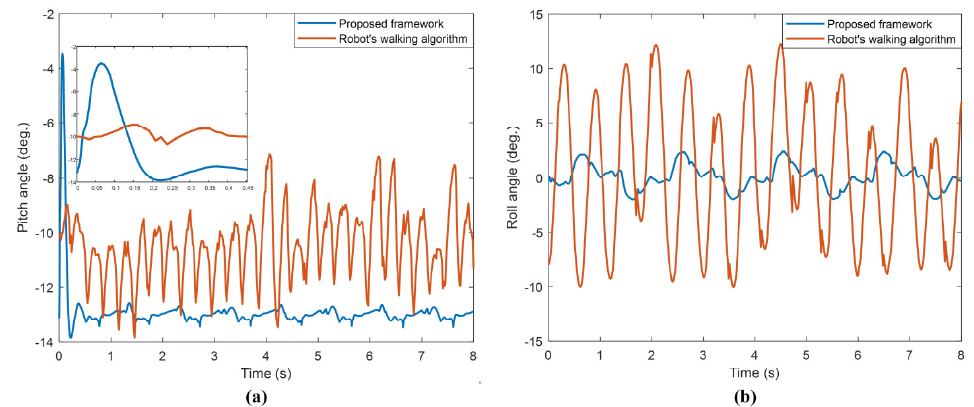
Figure 21. Comparison of orientation angles calculated with Kalman filter: ( a ) pitch angle, ( b ) roll angle.